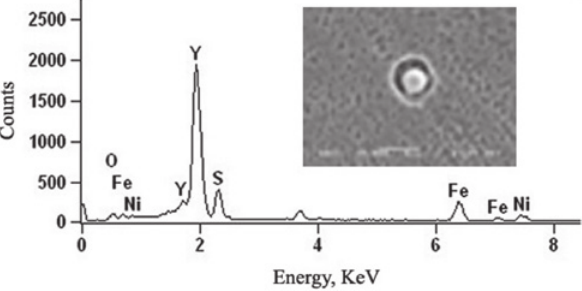
Fig. 4: SEM morphology and EDS spectra of the typical Y 2 O 2 S inclusion particle